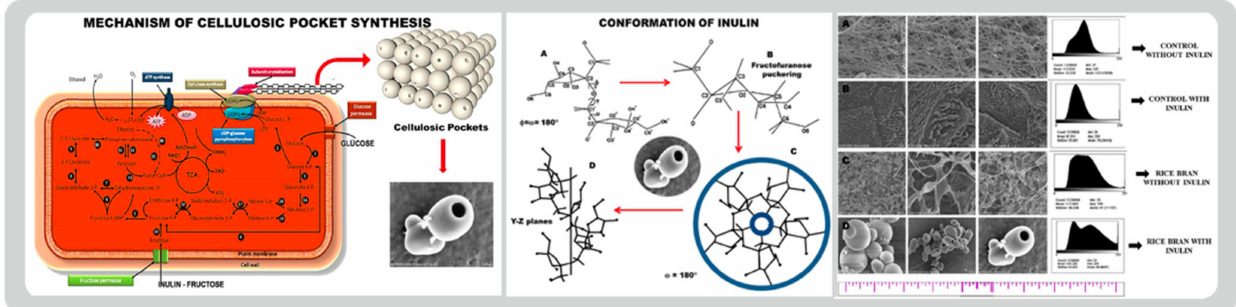
Figure 9. Presentation of bacterial cellulosic pocket synthesis mechanism and inulin conformation. Pocket dimensions and morphology are well illustrated: ( A ) is the inulin D-fructose molecule in all-trans conformation of φ = Ψ = ω = 180 while ( B ) is the ring puckering with C3 atom displacement. ( C ) is the proposed inulin conformation chain X-Y whereas ( D ) represents the Y-Z planes. Adapted with permission from